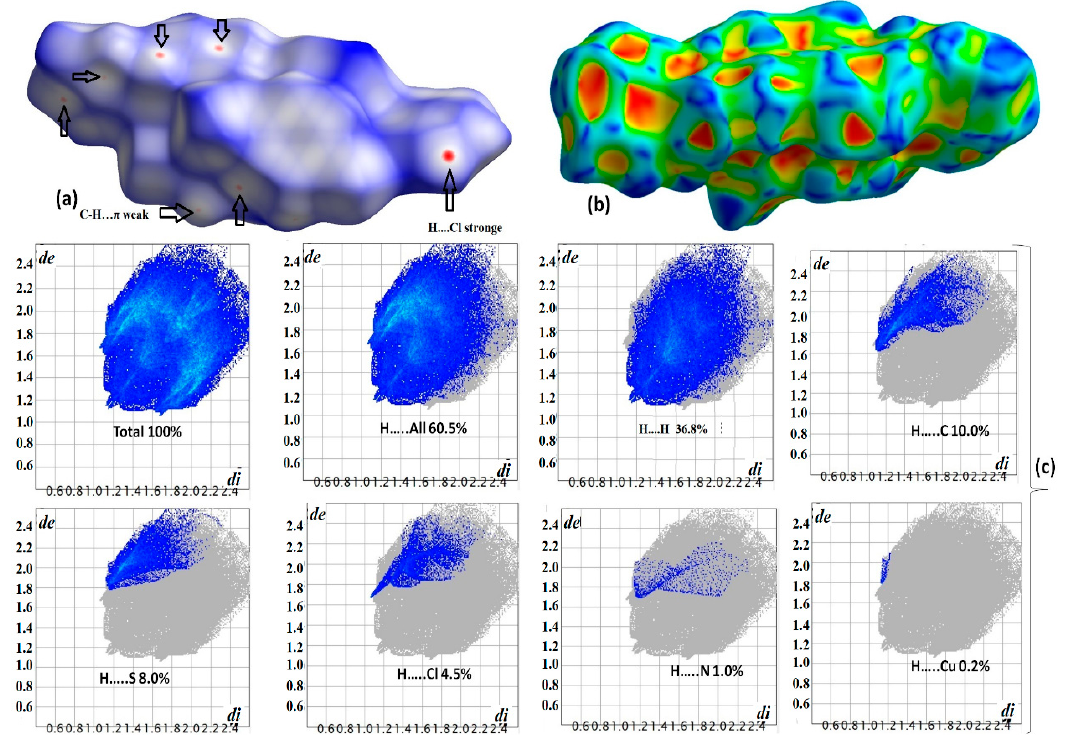
Figure 7. The d norm ( a ), shape index ( b ), and two-dimensional fingerprint (2D-FP) intermolecular contacts over the complex surface ( c ).